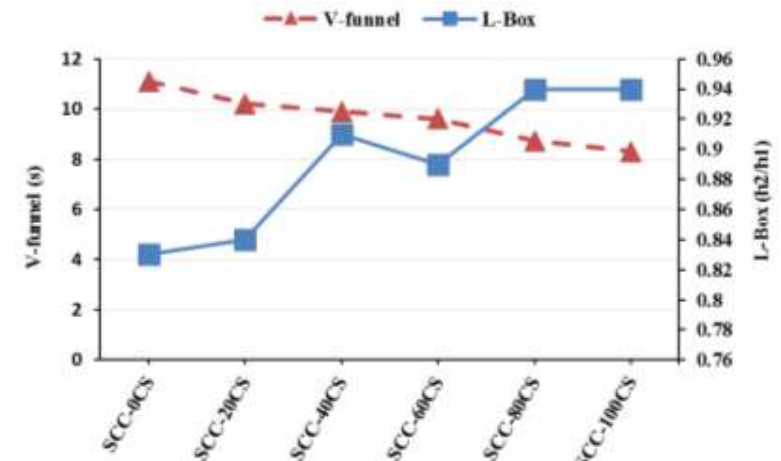
Figure 5. Variation of V funnel and L-Box tests for different percentages of copper slag replacement